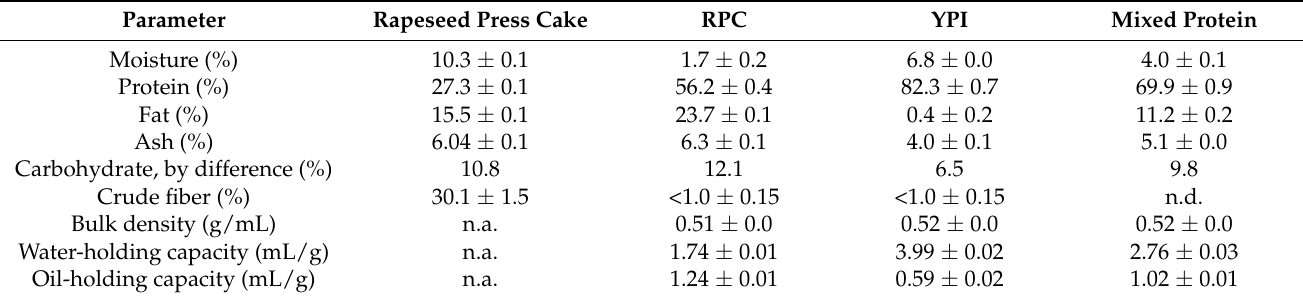
Table 2. Chemical characterization and functional properties of RPC, YPI, and the mixed protein.